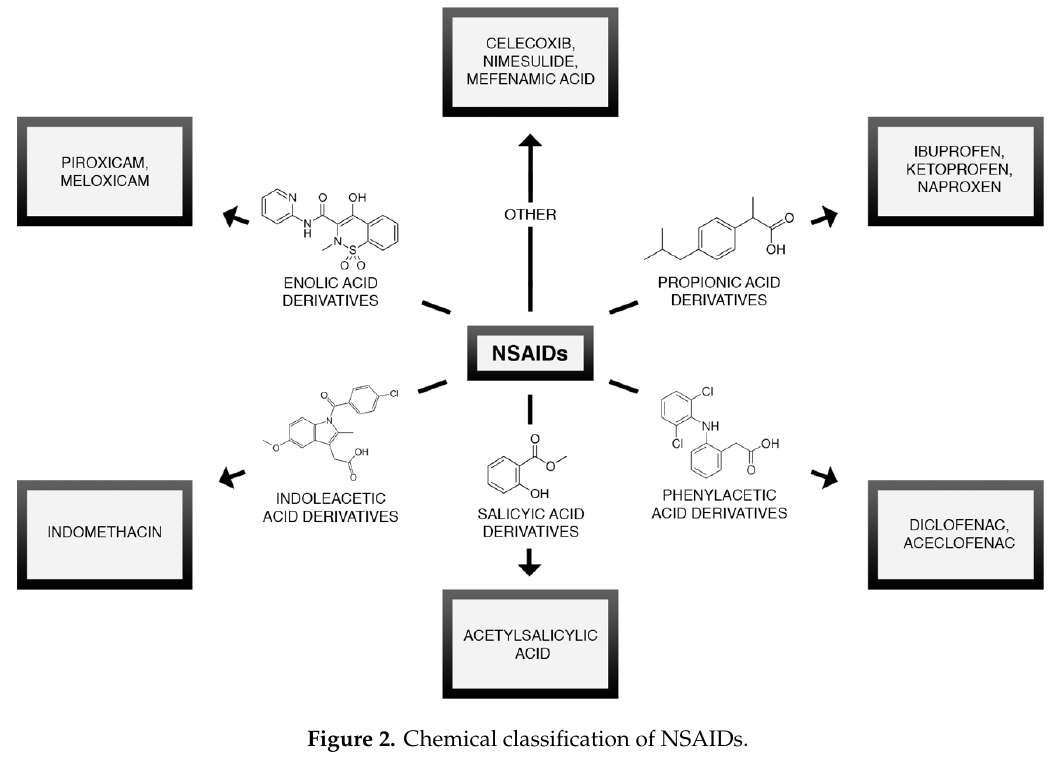
Figure 2. Chemical classification of NSAIDs.